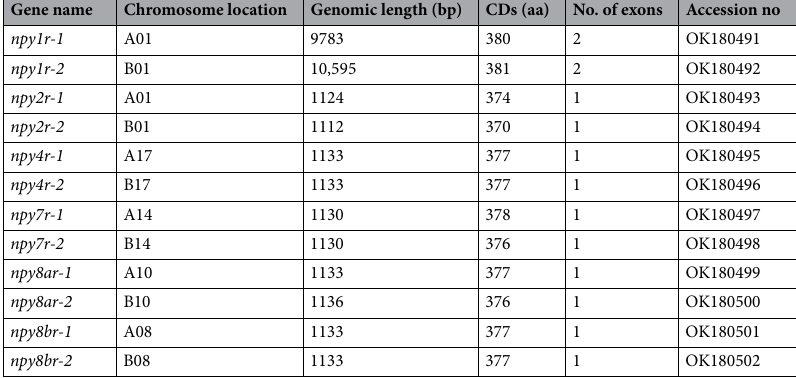
Table 1. Detailed information about neuropeptide Y receptor ( npyr ) gene in C.carpio